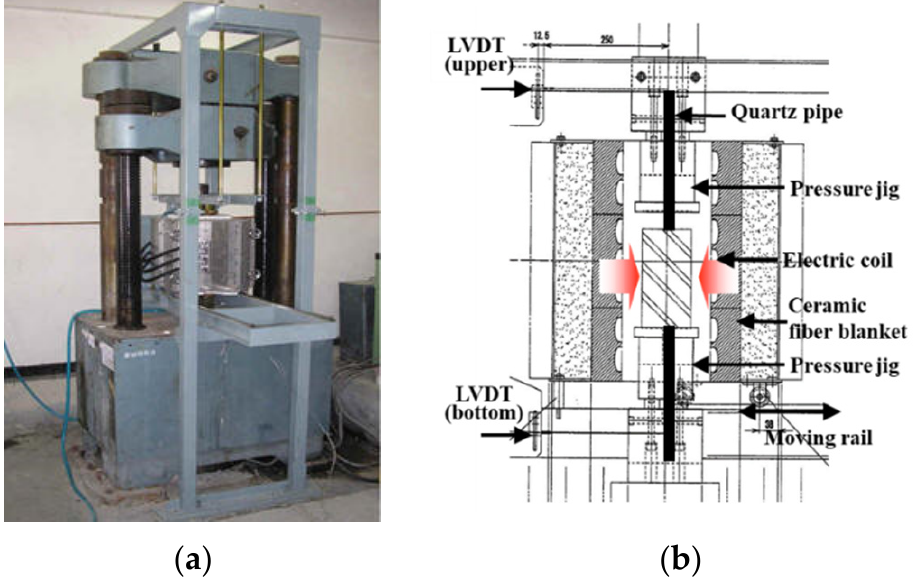
Figure 2. Loading system and electric furnace. ( a ) loding system. ( b ) electric